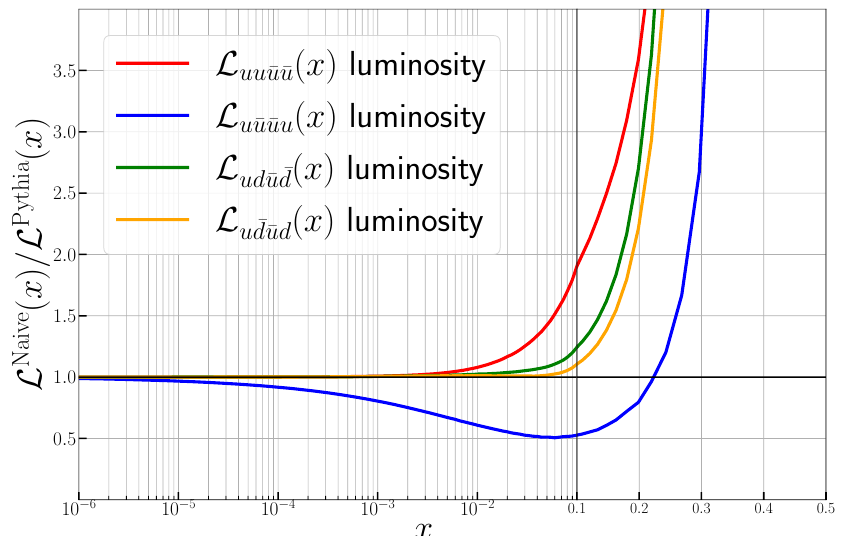
Figure 12 . Ratio of the DPS luminosities L Naive / L Pythia as a function of x where x 1 = x 2 = x 3 = x 4 = x .